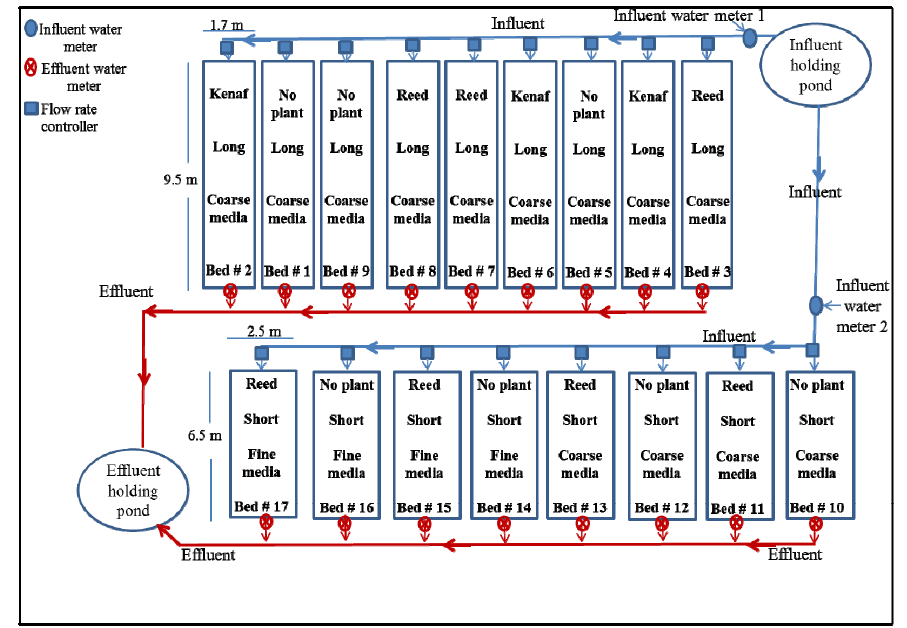
Figure 2. The horizontal sub-surface flow constructed wetland treatment (HSF-CW) system